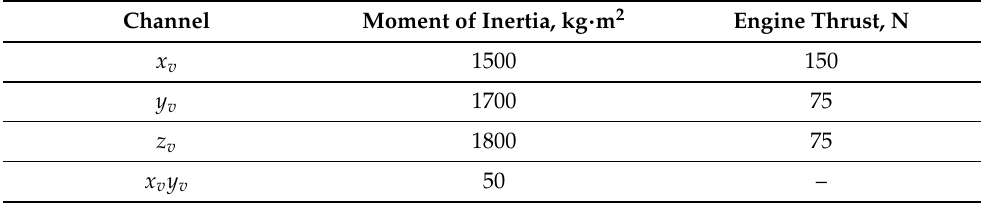
Table 3. Parameters of the spacecraft and engines (test